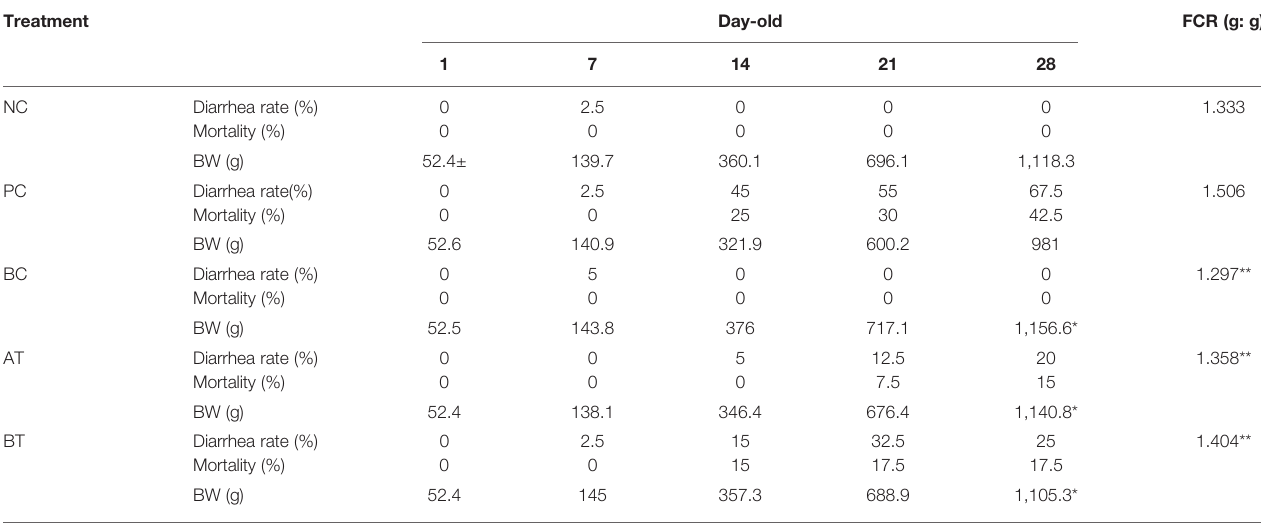
TABLE 2 | B. subtilis LF11 reduced the diarrhea and death of broilers challenged by Salmonella . Treatment